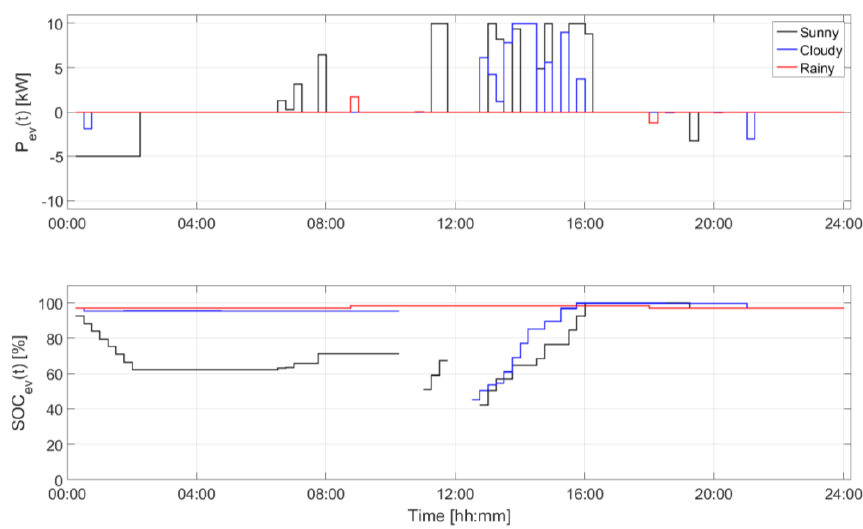
Figure 8. Power exchange between the test microgrid and EV 1 and the related SOC on the three days.